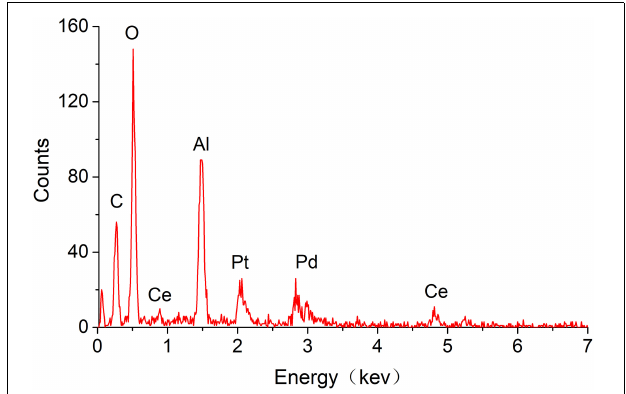
FIGURE 7 | Energy spectrum of sensor carrier.